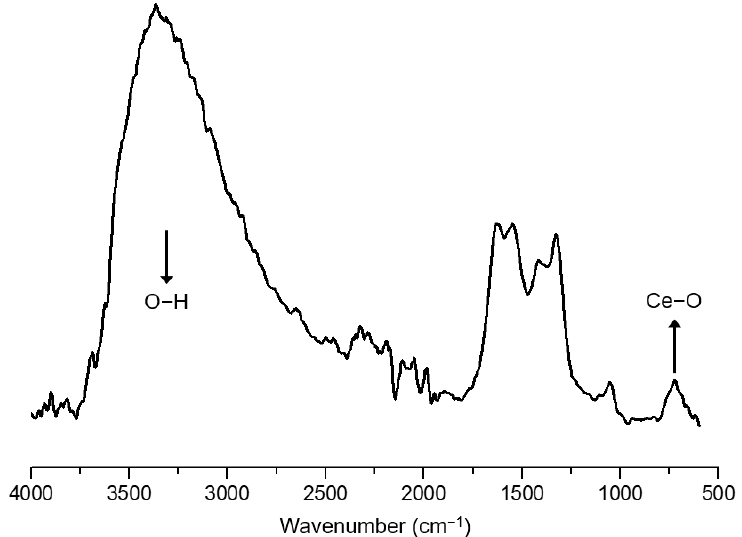
Figure 10. ATR-FTIR spectra of cerium oxide nanoparticles (CeO 2 NPs). The spectra were acquired between a 4000 and 600 cm − 1 wavenumber.